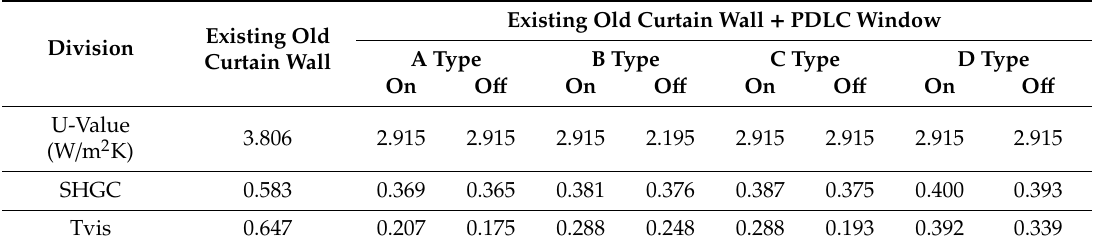
Table 10. Optical and thermal properties of the curtain wall system with PDLC